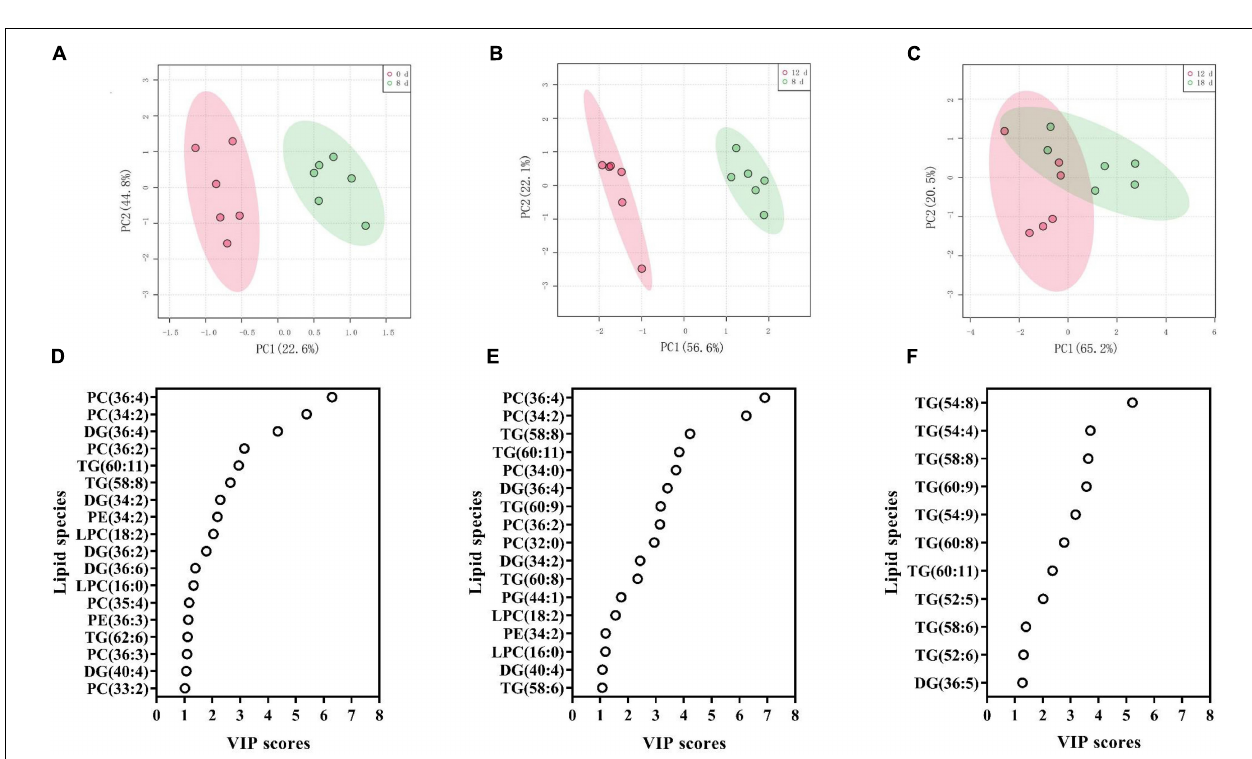
FIGURE 7 | PCA loading biplot illustrating the effect of 13 lipid molecules (PA, PC, PE, PG, PI, PS, LPA, LPC, LPE, LPG, MG, DG, and TG) on seed viability.